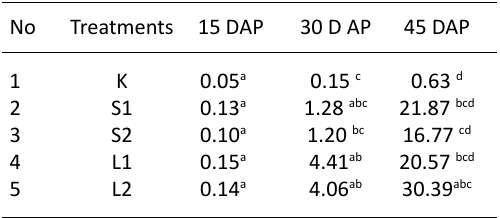
Table 3. Relative moisture content of plants (g). treated